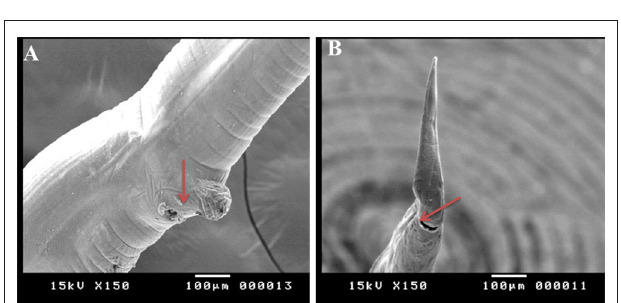
FIGURE 7 | Morphometric appearance of Haemonchus placei isolated from the abomasum of goats using scanning electron microscopy. (A) The vulvar region of female Haemonchus placei showing a reduced knob-like vulvar flap (arrow). (B) The tail region of female H. placei showing an anal pore (arrow). (C) The spicules of male H. placei showing split barbed tips (arrow).